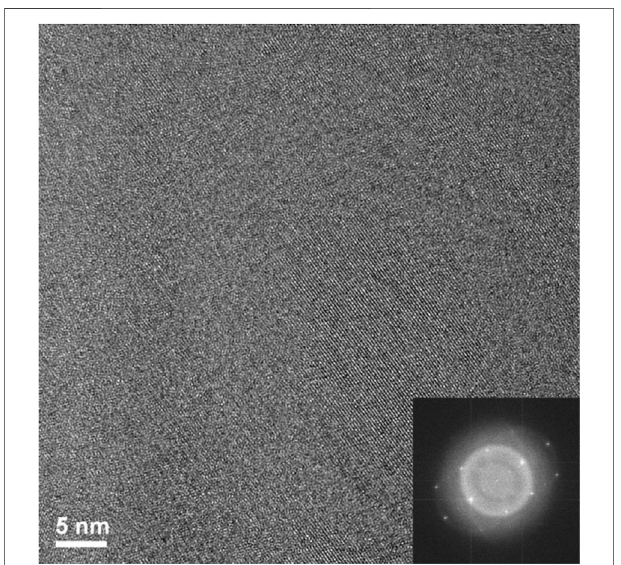
FIGURE 9 | Magni fi ed area of high-resolution region of irradiated Er 2 Ti 2 O 7 showing ordered and disordered regions.